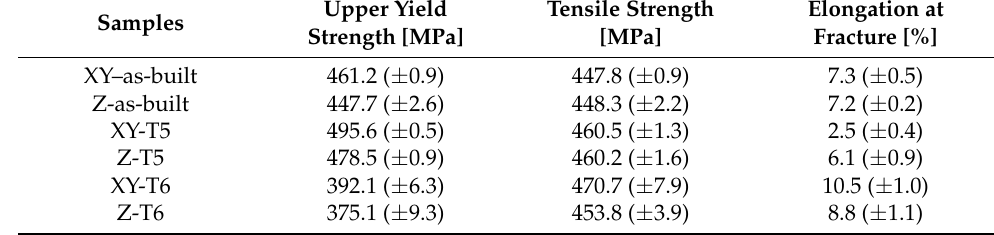
Table 5. Room-temperature mechanical properties of the as-built, T5 and T6 Ti/B-2618 alloys. Samples